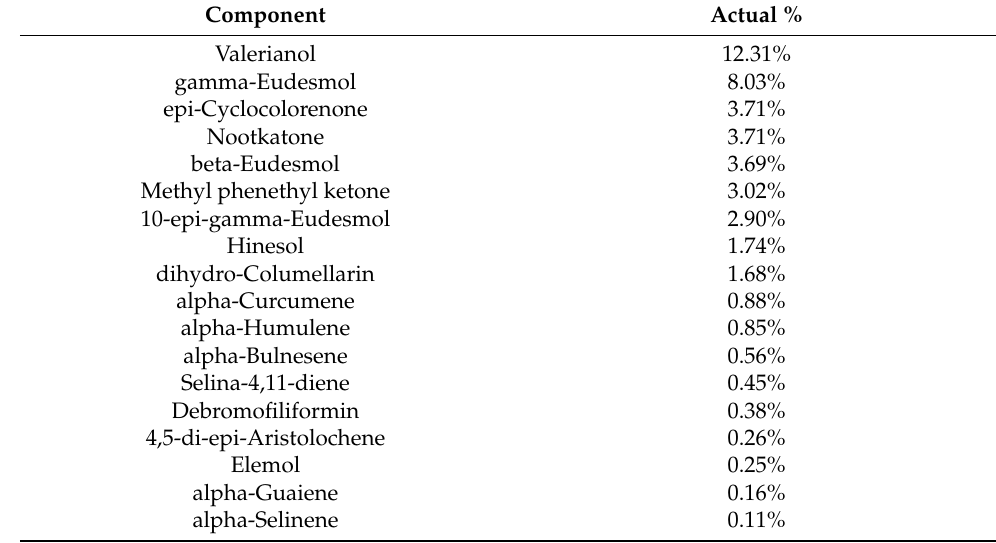
Table 1. Composition of the agarwood